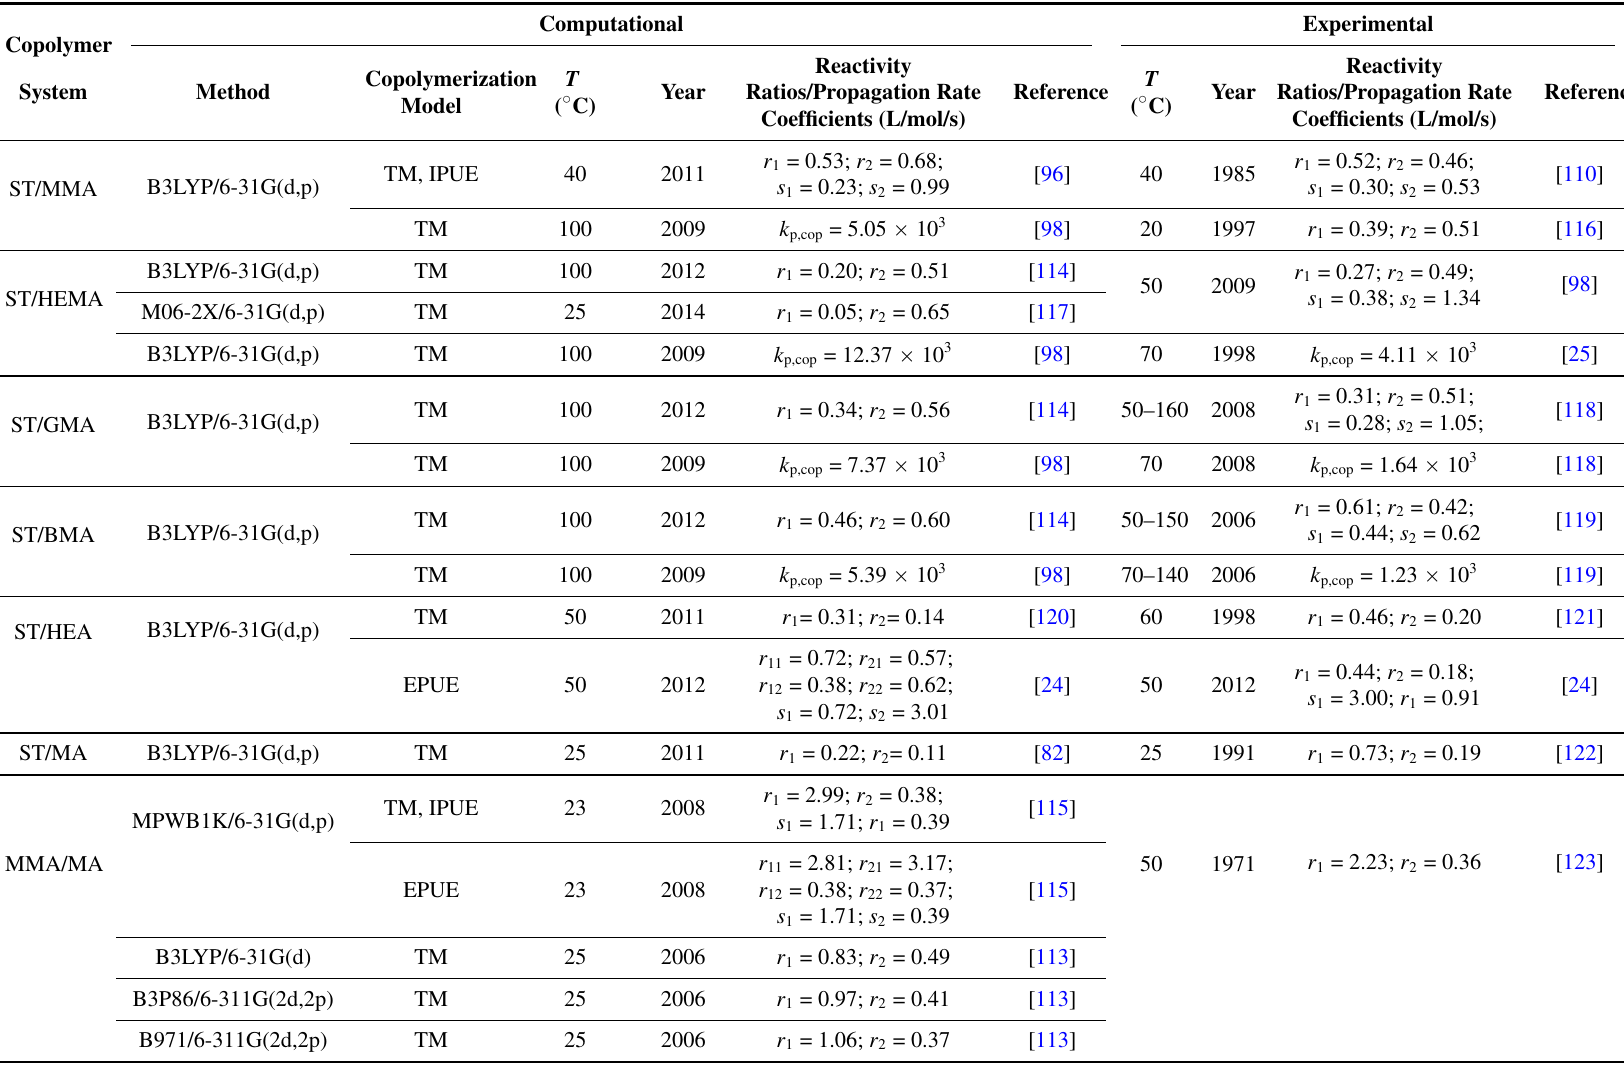
Table 3. Parameter values of the reactivity rations of various copolymer systems estimated by QC and comparison with experimental